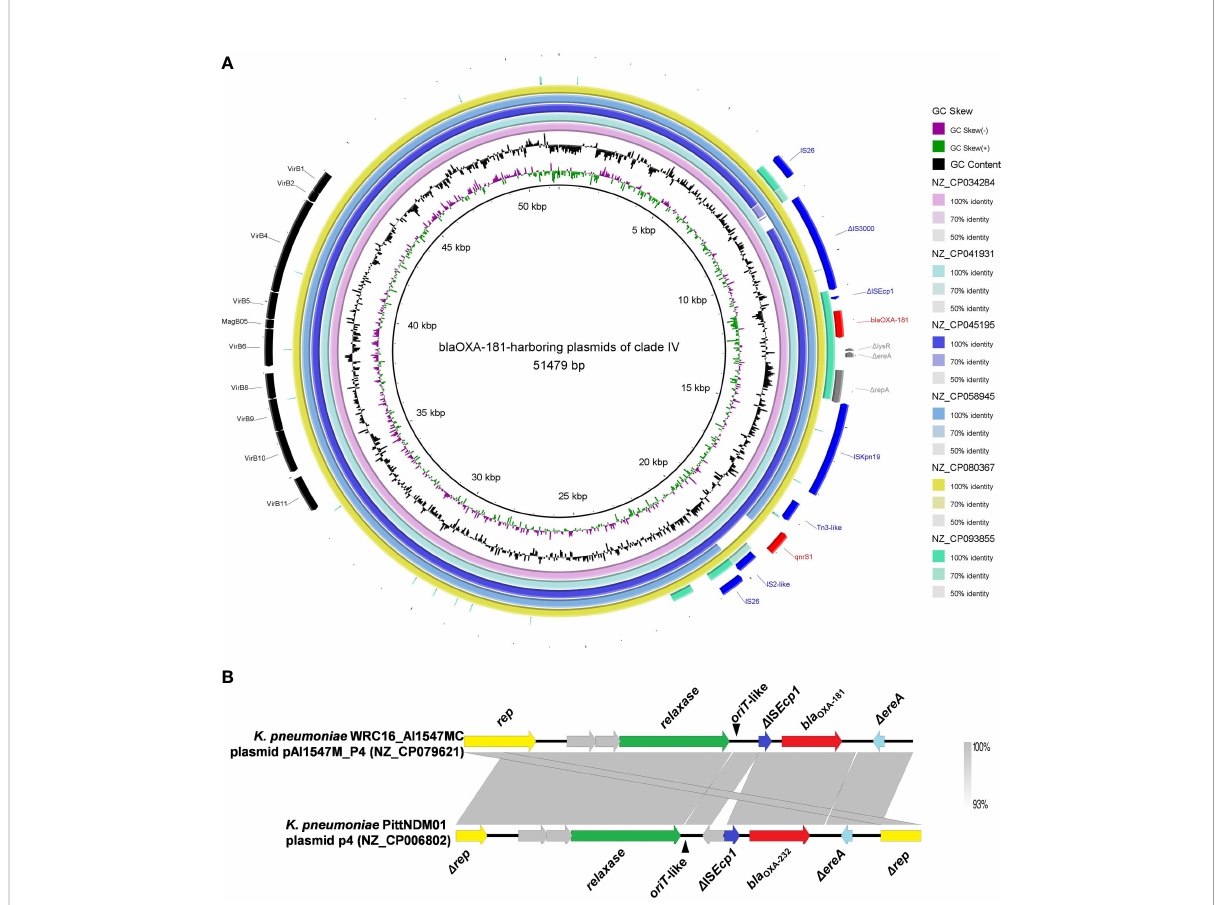
FIGURE 5 Characteristics of the conjugative transfer regions and genetic environment surrounding bla OXA-48-like carried by the plasmids belonging to clade IV and clade V. (A) Details of the VirB-like T4SS gene clusters and bla OXA-181 -associated genetic structures identi fi ed among the six bla OXA-181 - harboring plasmids clustered into clade IV. (B) The oriT -like regions and the genetic context surrounding the bla OXA-181 or bla OXA-232 genes of the small plasmids belonging to clade